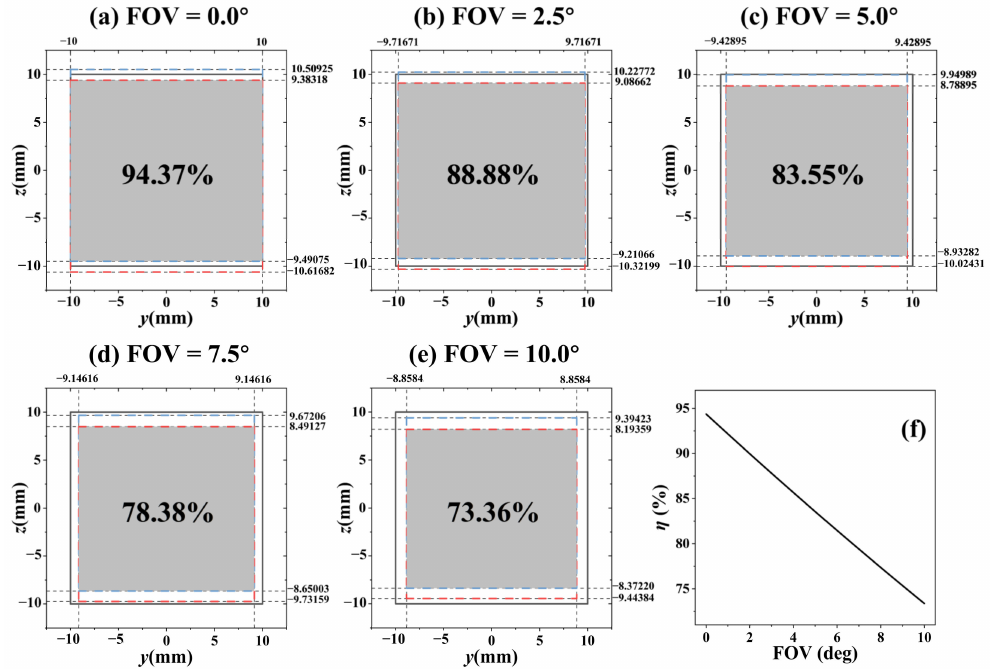
Figure 15. When s = 0 mm, FOV = 0–10 ◦ : ( a – e ) Effective incident aperture of DWP; ( f ) Variation in luminous flux utilization with